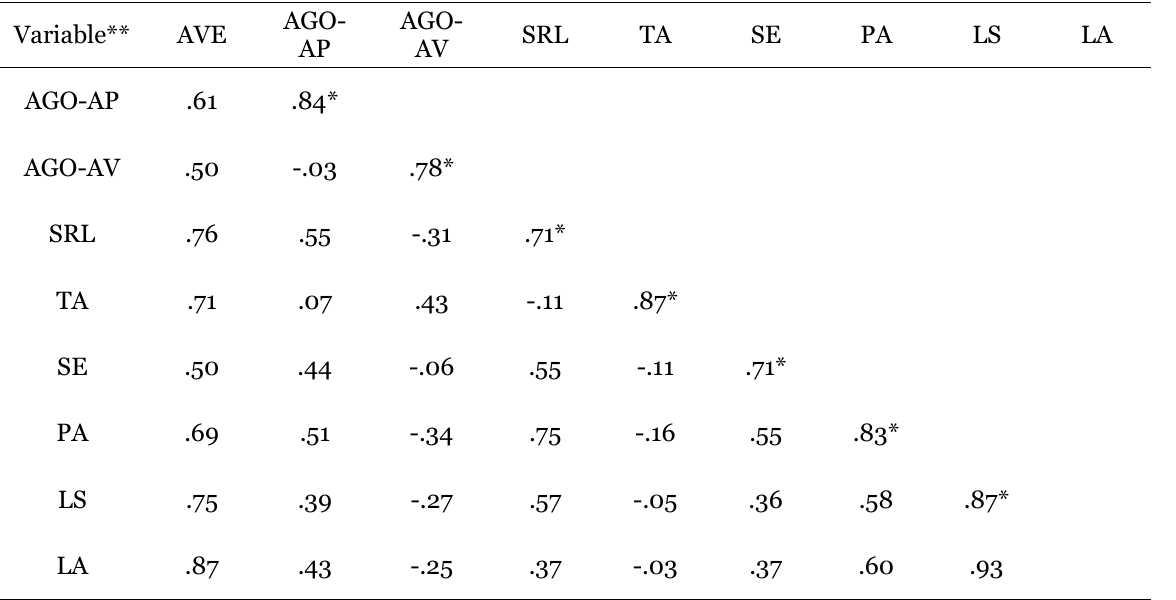
Correlation Matrices and Discriminant Validity Among